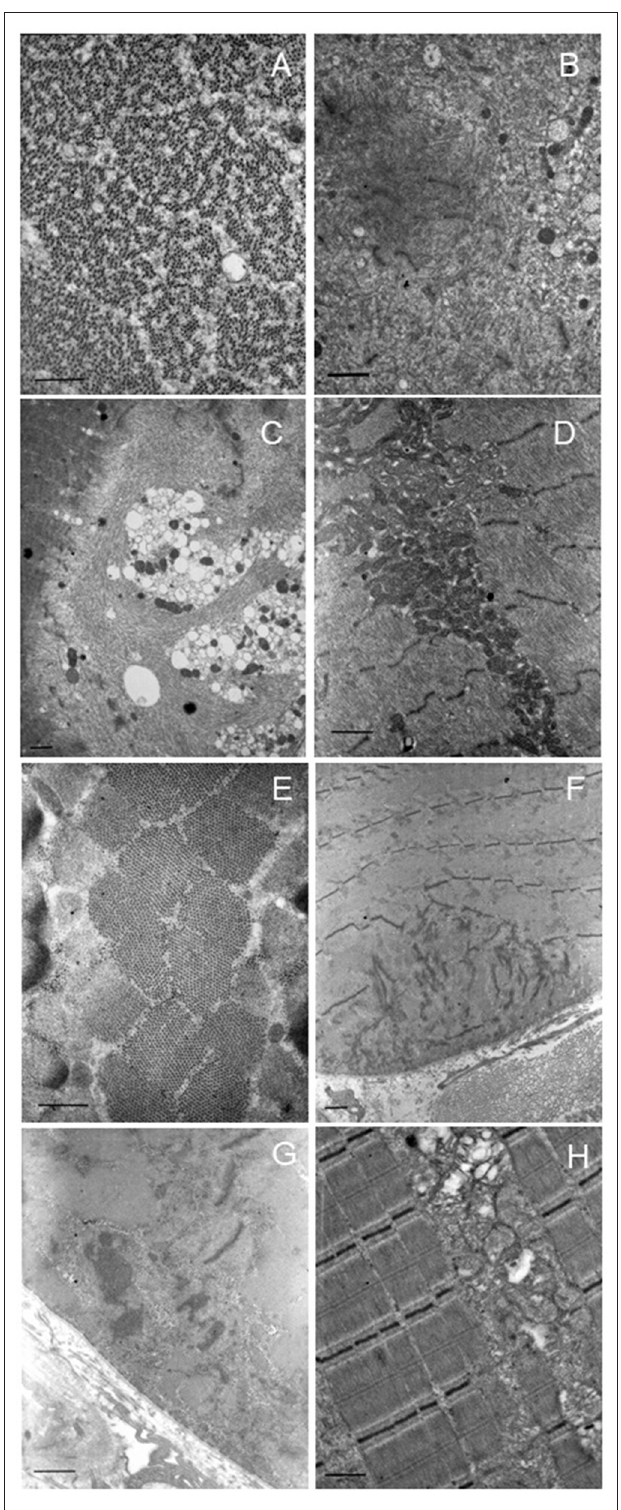
FIGURE 2 | Electron microscopy. Representative images of patients 1 (A–D) and 2 (E–H) . Patient 1: altered ultrastructural sarcomere pattern in transverse section (A) . Degeneration of sarcomere structure with extended area of